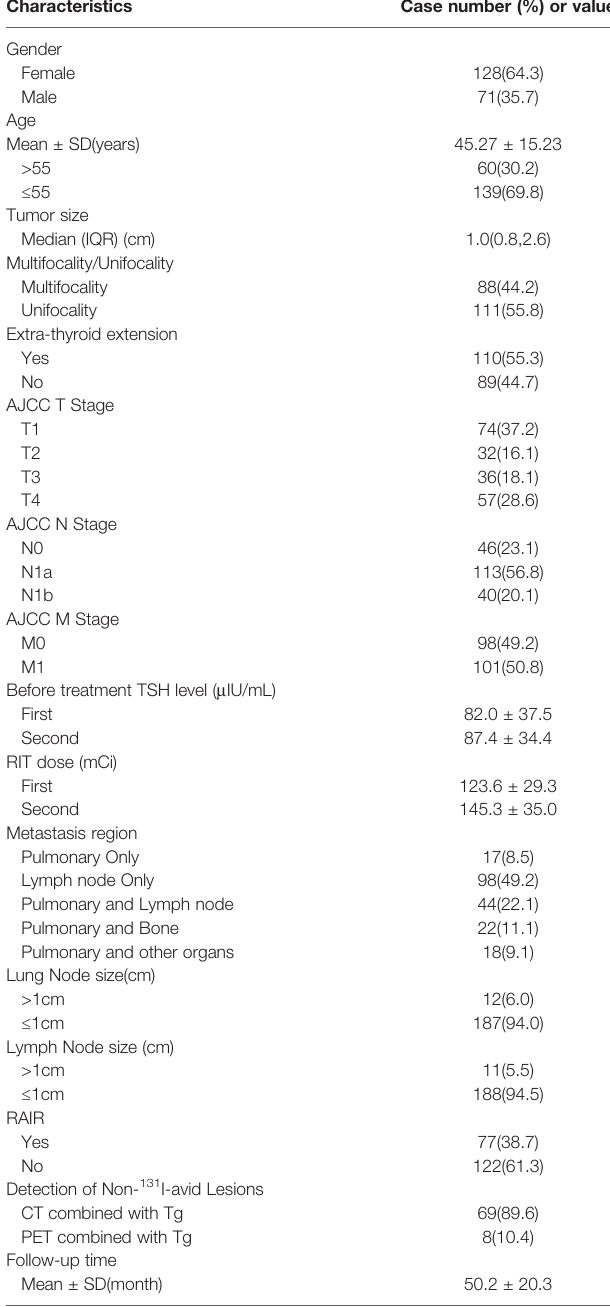
TABLE 1 | Clinical and pathological characteristics of the included patients.